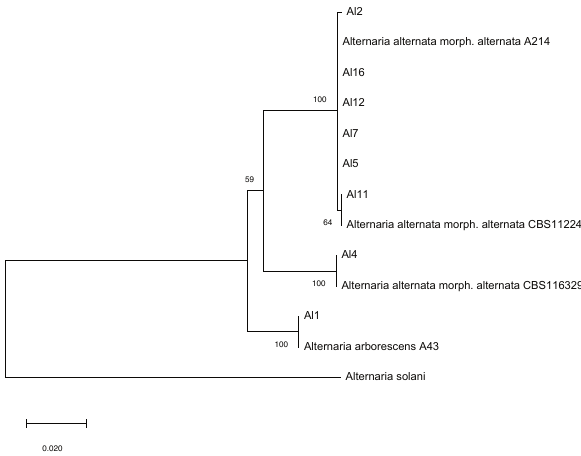
Figure 6. Phylogenetic tree for Alternaria strains based on a por- tion of the SCAR Marker OPA1-3. Numbers on nodes represent the Maximum Likelihood bootstrap percentages. Branch lengths are proportional to the numbers of nucleotide substitutions and can be measured using the bar scale